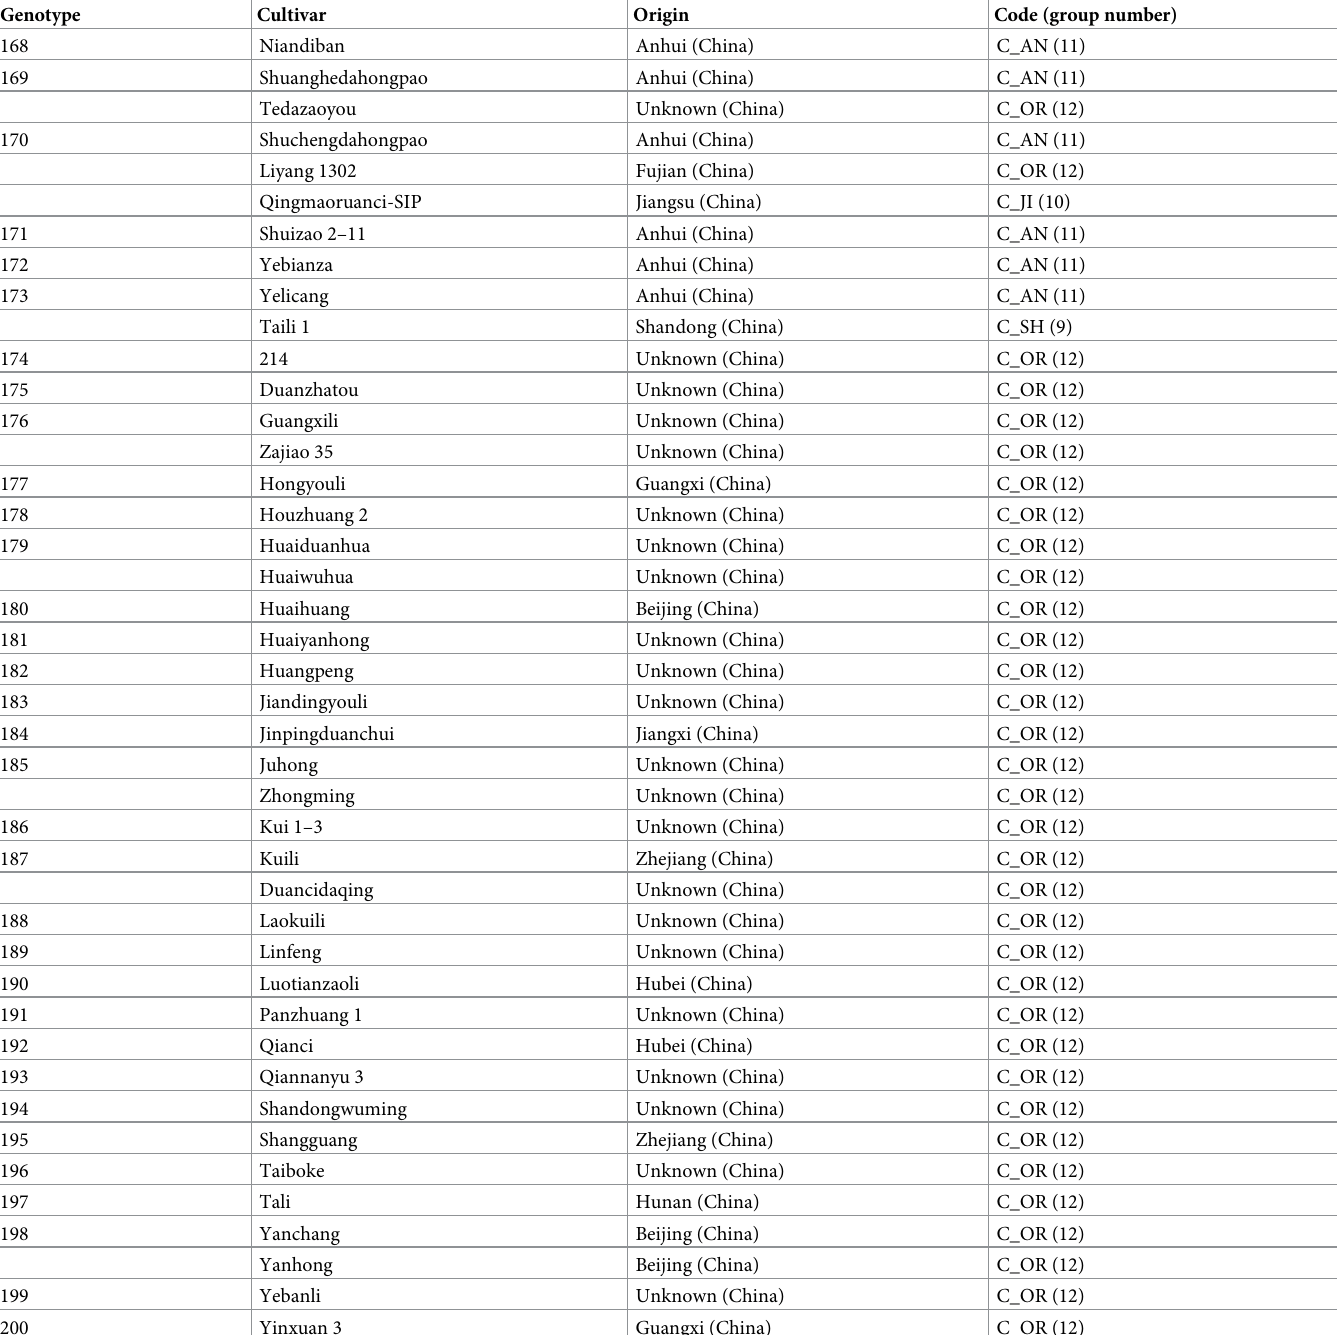
Genetic markers The 230 cultivars were genotyped for 31 nuclear SSRs [26–28] (S2 Table) and 5 chloroplast SSRs (cpSSRs) (Cmcs1–3, Cmcs5, and Cmcs7) [29]. PCR amplification was performed in a